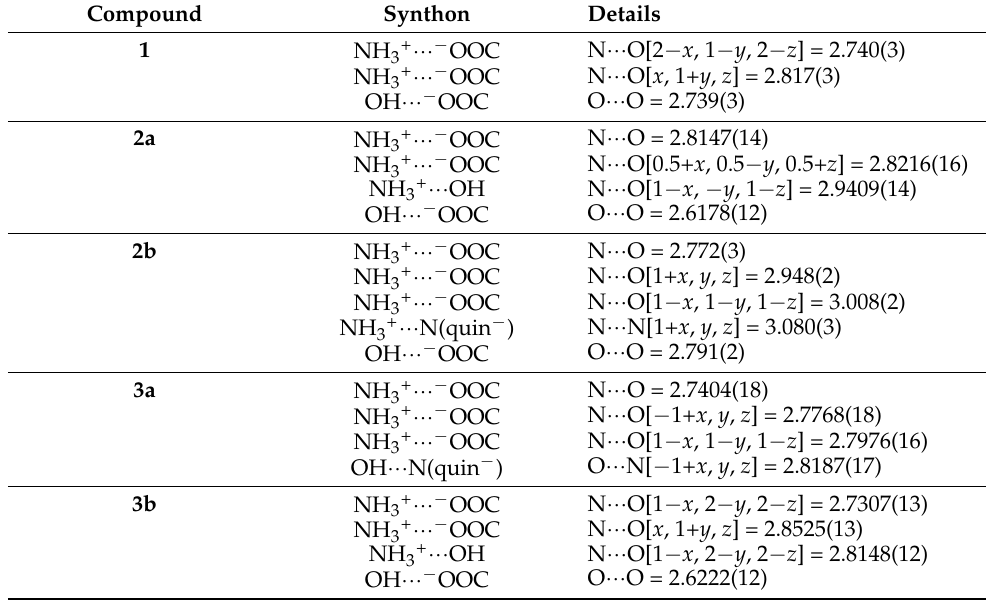
Table 2. Hydrogen bonds (Å) in title